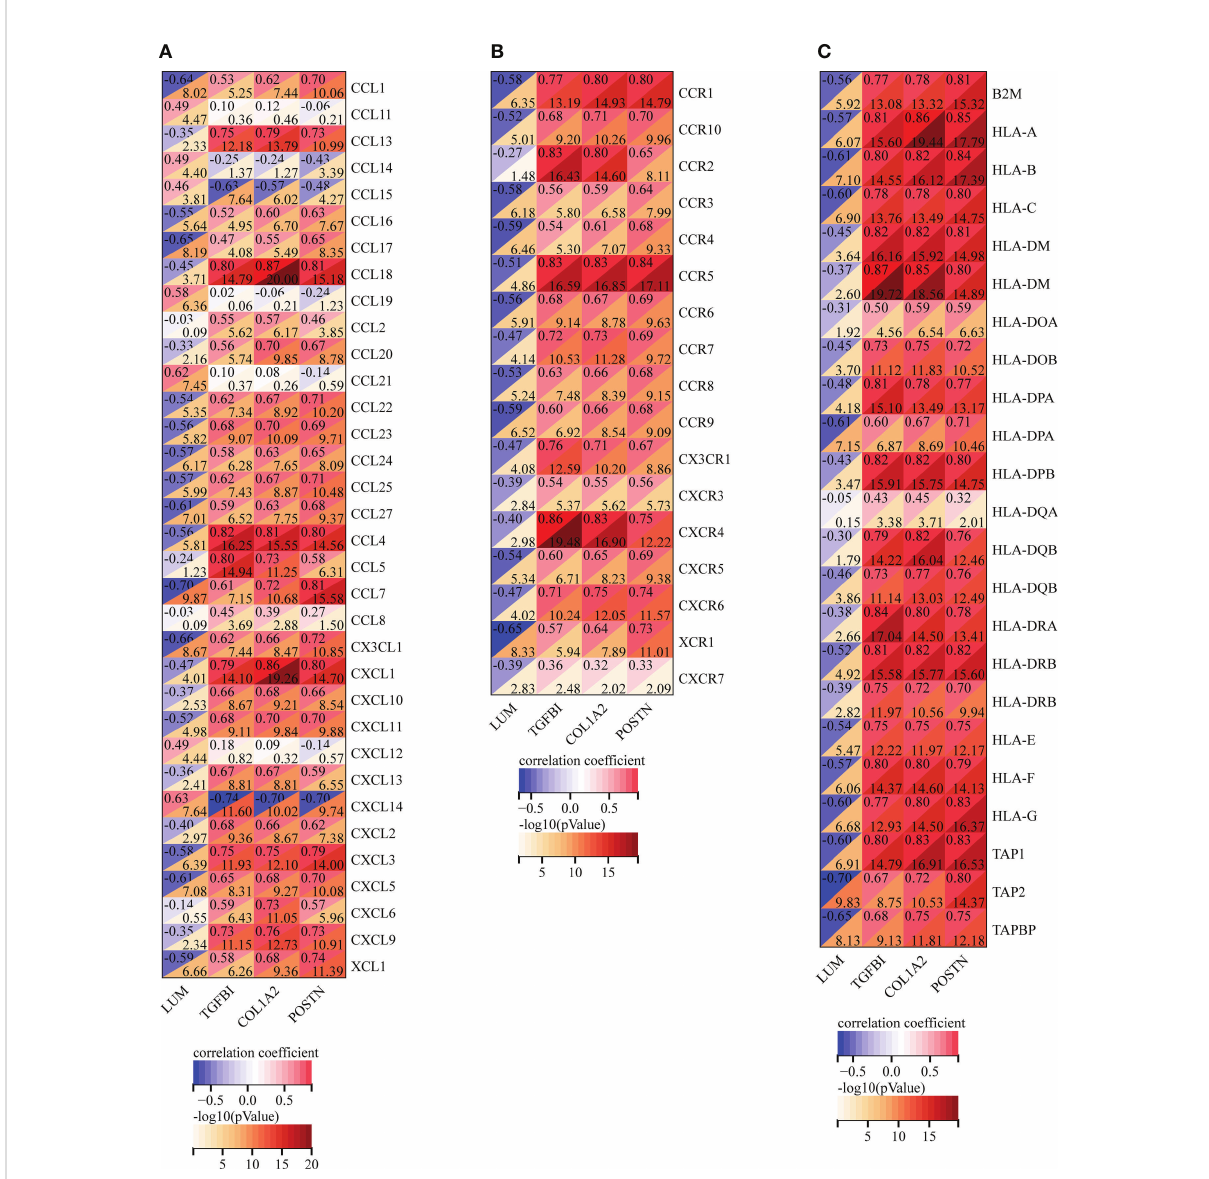
FIGURE 8 Correlation analysis of the expression of LUM, TGFBI, COL1A2, and POSTN with immunoregulatory genes, including (A) chemokines, (B) chemokine receptors, and (C) MHC